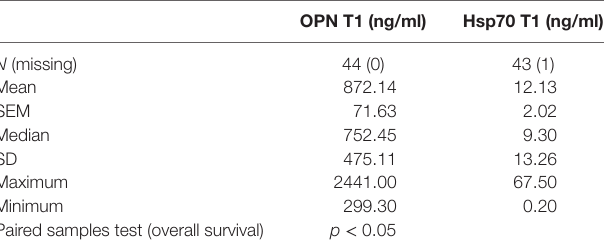
Table 4 | Comparison of heat shock protein 70 (Hsp70) plasma levels before (T1) and 4–6 weeks after (T2) radio(chemo)therapy in non-small-cell lung cancer patients (M0).